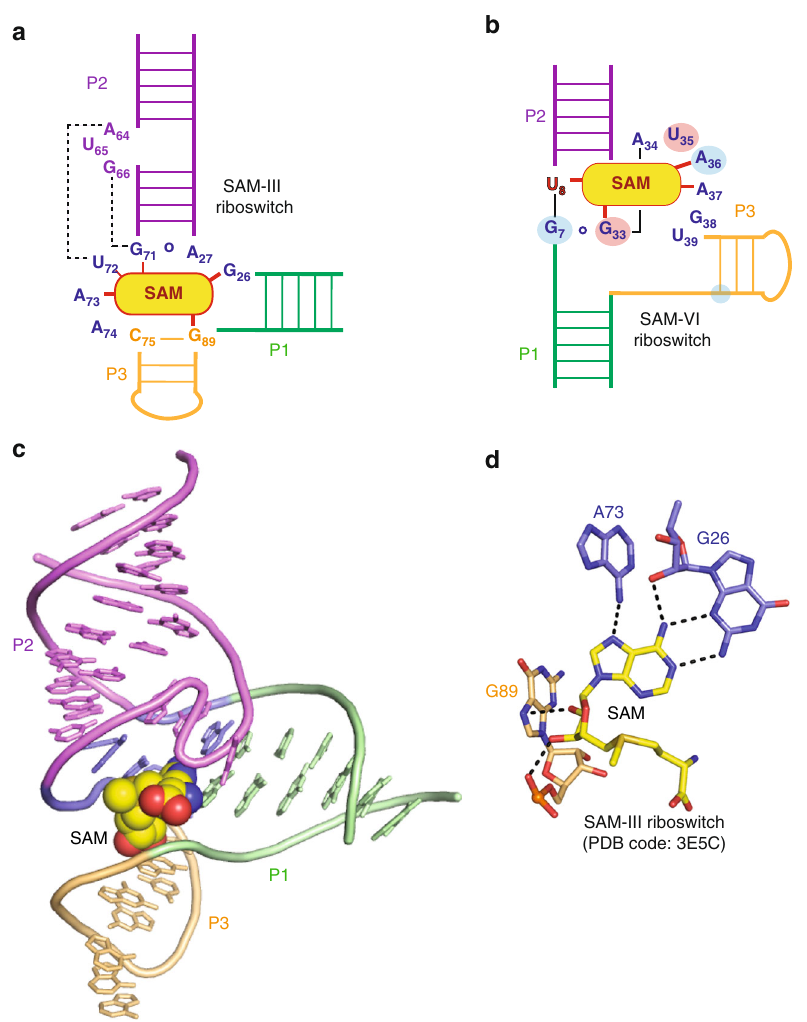
Fig. 6 Comparison of secondary structures, tertiary folds, and binding pockets of SAM-III and SAM-VI riboswitches. a, b Secondary structure schemes of SAM-III ( a ) and SAM-VI ( b ); nucleotides crucial for the ligand recognition are assigned and direct interactions are highlighted by red lines. The residues in SAM-VI that are equivalent in interaction with the ligand compared to SAM-III are shown with light red (electrostatic interaction) and light blue (hydrogen-bonding interaction) shadow. Note that the same helix color code is applied for SAM-III and SAM-VI. c Cartoon representations of the tertiary structure of SAM-III bound to SAM (PDB code: 3E5C); helix colors are as in a . d Binding interactions of SAM ligand with the SAM-III RNA pocket. SAM- adenine adopts a syn conformation in SAM-III while it is anti in SAM-VI. SAM-adenine interacts with the sugar edge of a guanosine (G26) through its Watson-Crick edge in SAM-III while it is the Hoogsteen face of SAM-adenine that pairs with the Watson-Crick face of a uridine (U8)